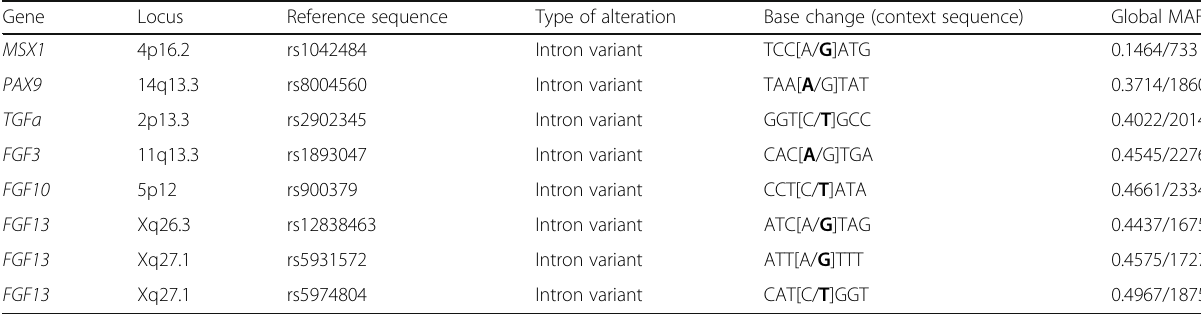
Table 1 Studied genetic polymorphisms